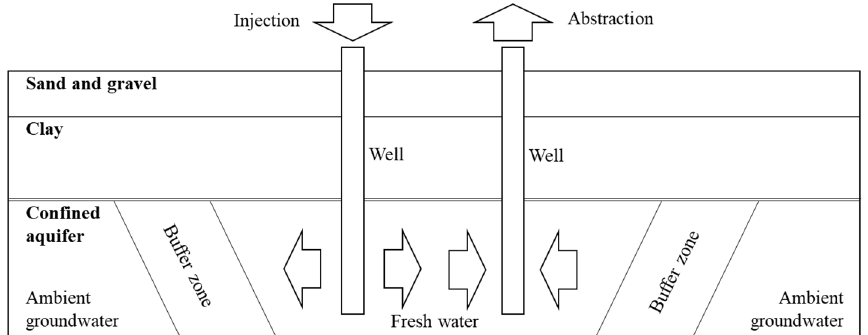
Figure 1. Schematic of the aquifer storage transfer and recovery (ASTR) technique.